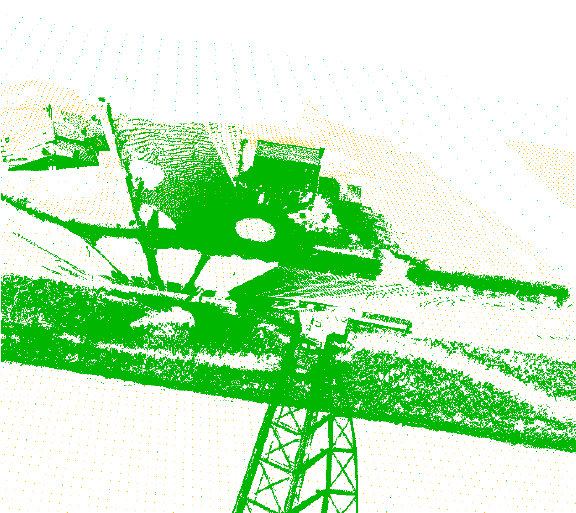
Figure 3. Top view of the point cloud showing the most sensible parts; the bridge can be clearly seen, along with the northern